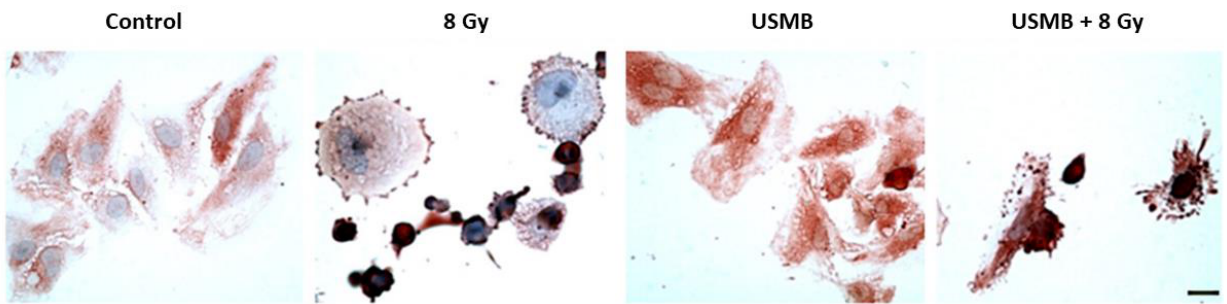
Figure 4. Ceramide immunohistochemical staining in HUVEC treated with USMB, XRT, and USMB + XRT. Cells were treated with XRT alone, USMB alone, and a combination of USMB and 8 Gy. Images captured at high magnification indicate higher ceramide staining in the combined treated group of USMB and 8 Gy. Ceramide stains were also noted in the radiation-only group of 8 Gy; however, the staining was less intense compared to combined treatment. Control group cells appeared to have lesser ceramide staining. The scale bar represents 25 µm. Abbreviations: HUVEC — human umbilical vein endothelial cells; USMB — ultrasound-stimulated microbubbles; XRT — radiation therapy. Adapted with permission from [87].